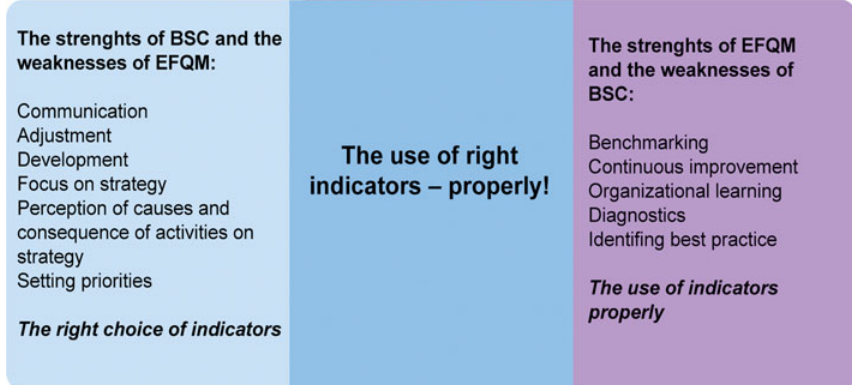
Fig. 6. Benefits of the